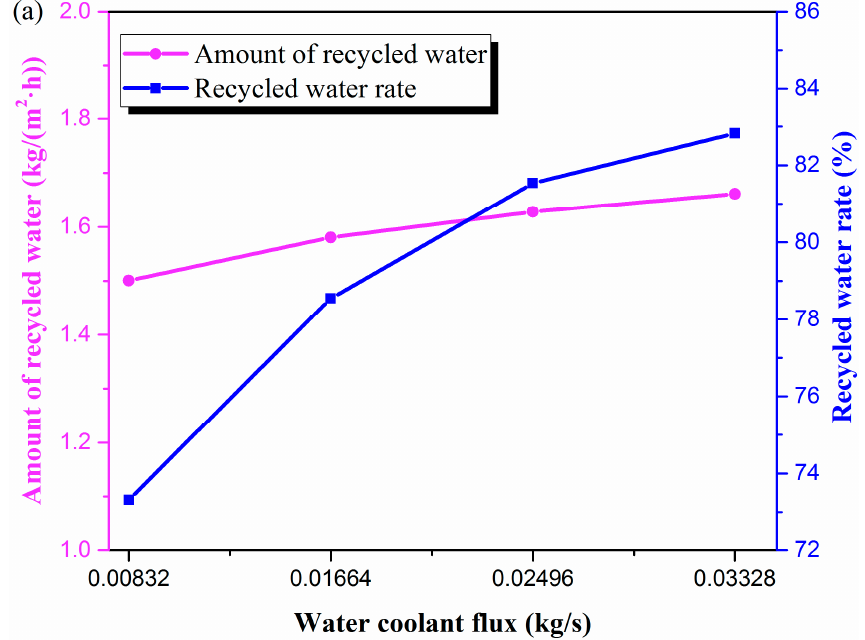
Figure 6. Membrane performance changes with water coolant flux in terms of ( a ) water, ( b ) heat, and ( c ) THTC. (Experimental conditions: flue gas flow rate 1.875 × 10 − 4 kg / s, flue gas temperature 50 ◦ C, water coolant temperature 20 ◦